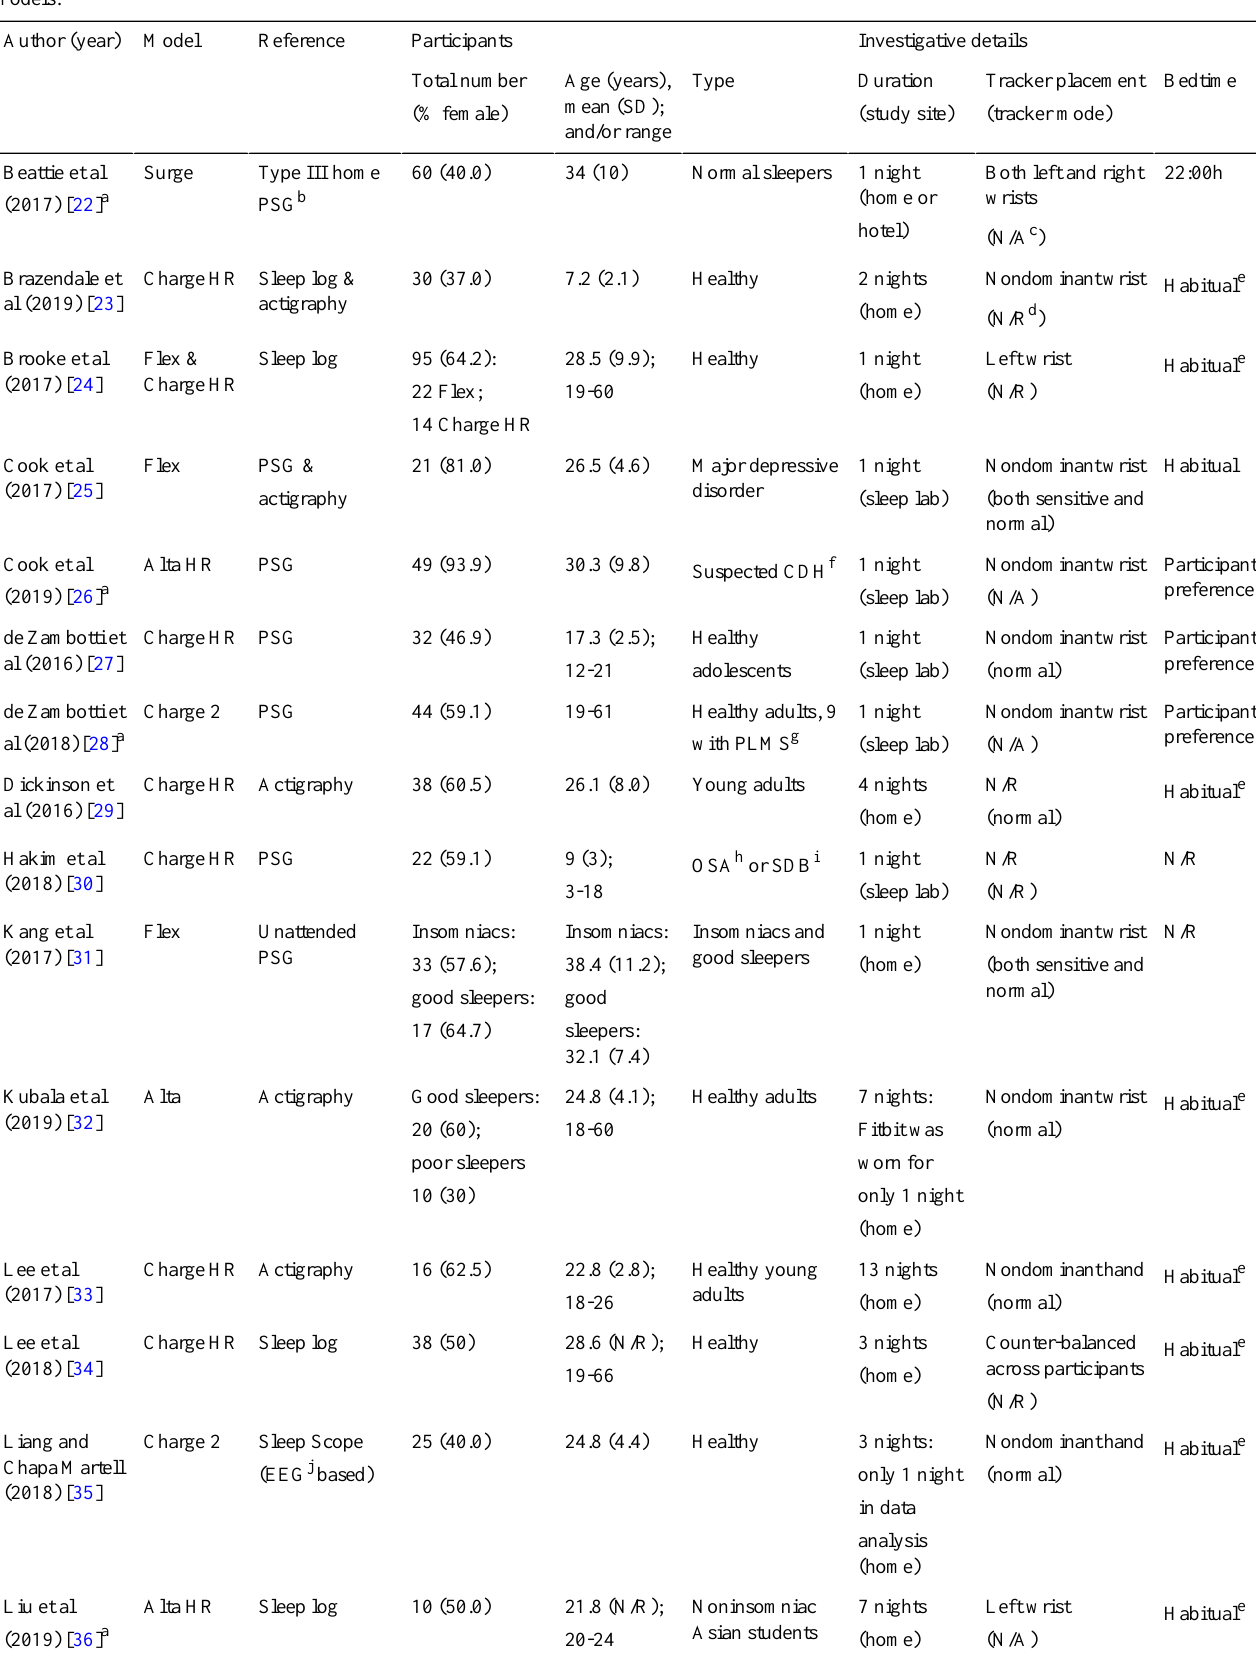
Table 1. Detailed summary of qualifying publications involving both early-generation, nonsleep-staging and newer-generation, sleep-staging Fitbit